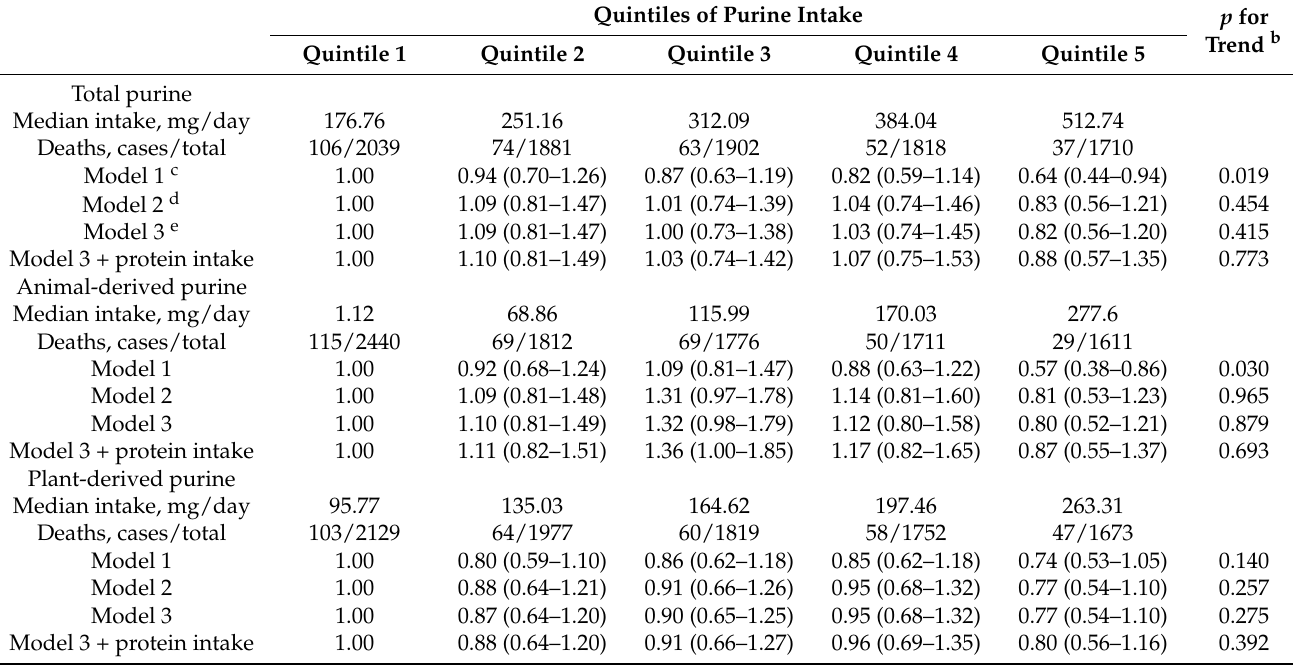
Table 4. HRs (95% CIs) of mortality according to the quintiles of purine intake in females a .